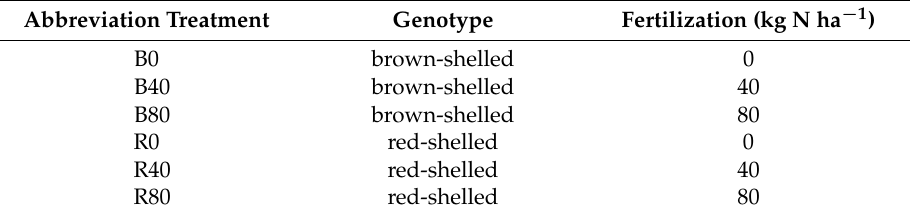
Table 1. List of two used genotypes (B = brown-shelled, R = red-shelled) and three different N fertilization levels (0, 40, and 80 kg N ha − 1 ). Given abbreviations for each treatment will be used throughout the